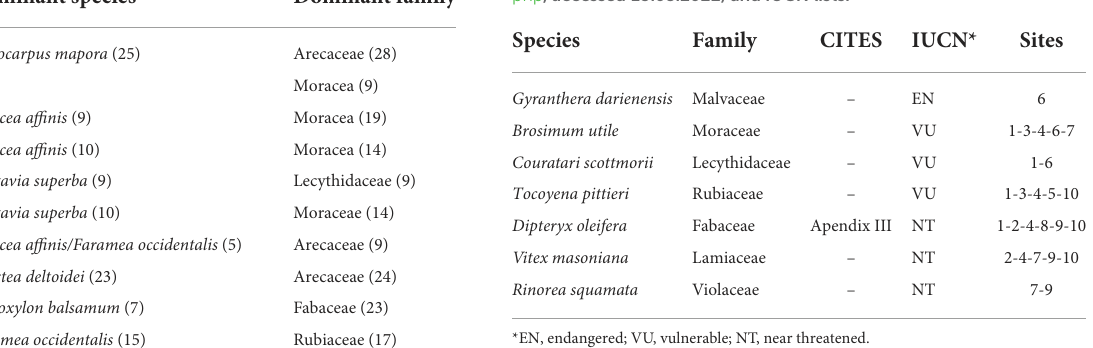
TABLE 2 Conservation status of threatened species encountered using both CITES Appendix II ( https://cites.org/eng/app/appendices. php , accessed 15.08.2022) and IUCN